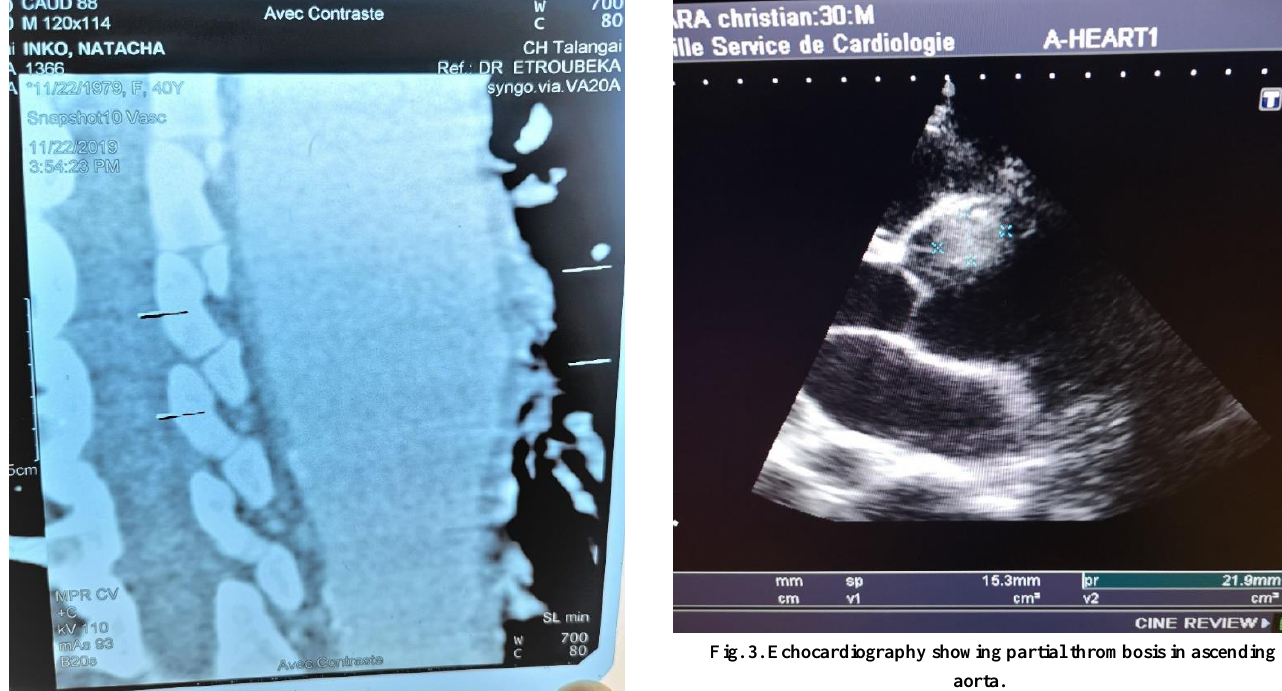
Fig. 2. Computed tomography shows dilation of the aorta with a fusiform aneurysm.